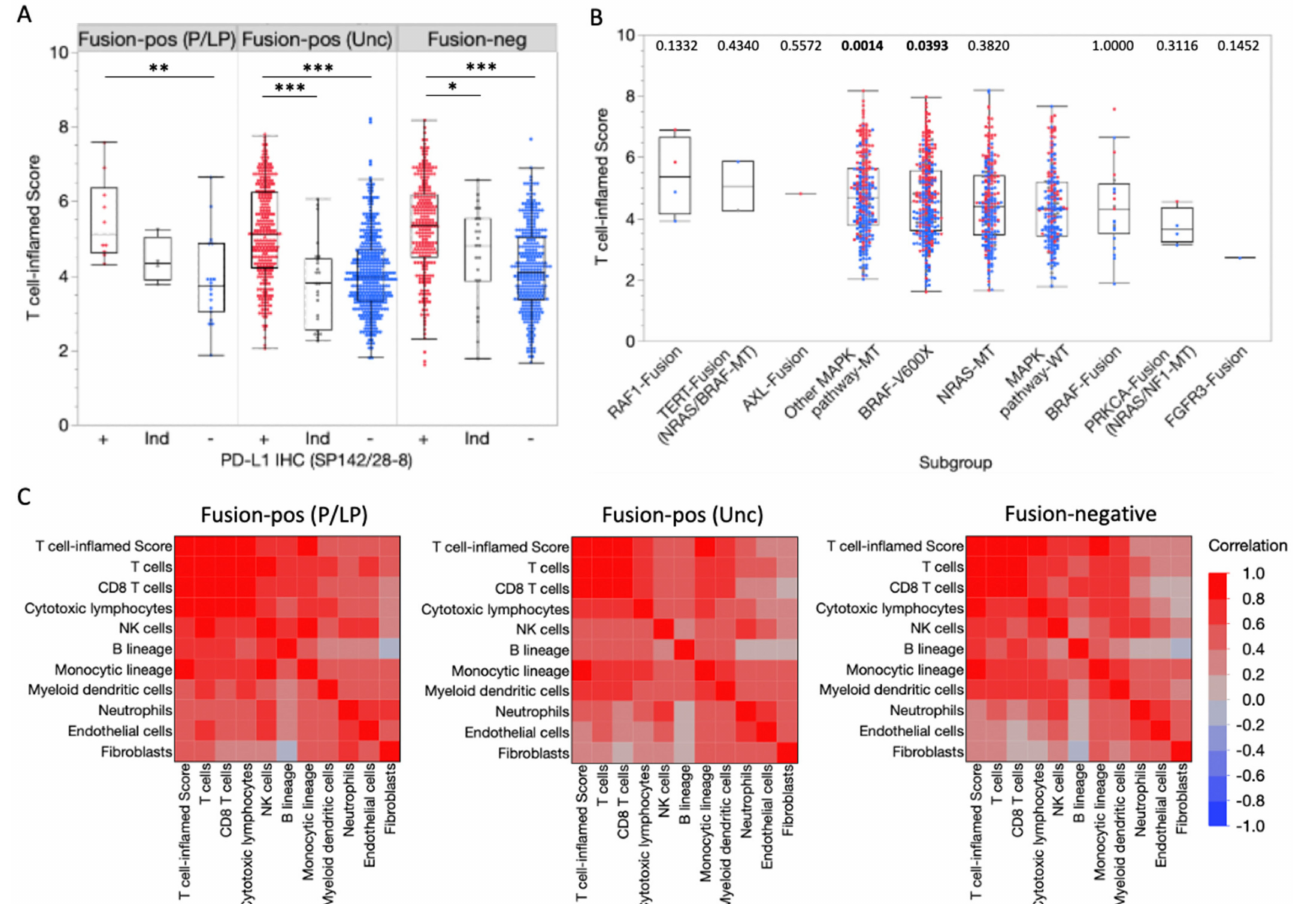
Figure 4. Transcriptional profiling of the tumor microenvironment. ( A ) T cell-inflamed scores in fusion-positive and fusion-negative tumors according to PD-L1 IHC (SP142/28-8) status (Red = positive [+], Blue = negative [–], gray = Indeterminate [Ind]). * p < 0.05, ** p < 0.01, *** p < 0.0001. ( B ) T cell-inflamed scores in subgroups based on detected fusions or MAPK pathway alterations (co-alterations noted in parentheses). p -values (Mann-Whitney U) noted above